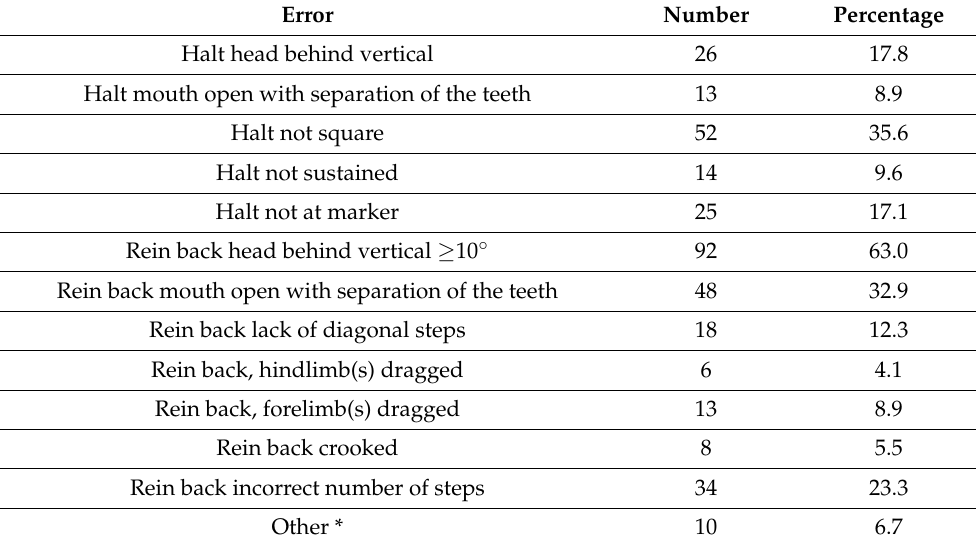
Table 7. Summary of the frequency of occurrence of errors in the movement “halt at C-immobility- rein back five steps-proceed in collected trot” for all venues combined (146 competitors) for World Cup Grand Prix Western League qualifying competitions ( n = 7) and finals ( n = 2). The median score was 2/13 (interquartile range 1, 3; range 0,